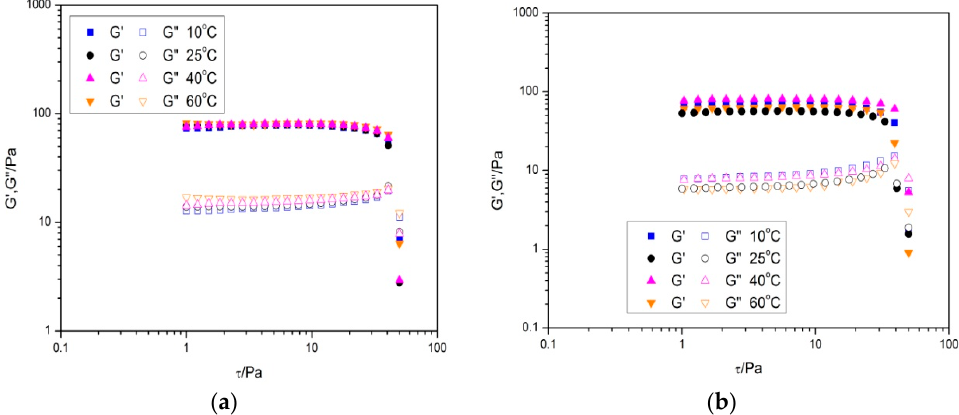
Figure 1. Influence of the temperature on the linear viscoelastic region of aqueous solutions containing ( a ) 1 wt % diutan gum and ( b ) 1 wt % rhamsan gum.